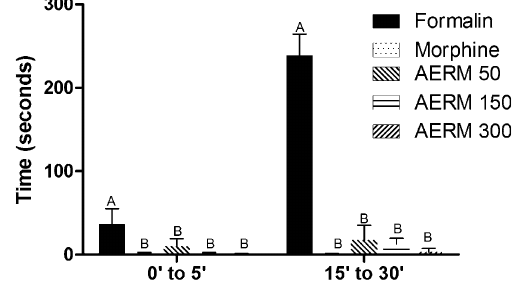
Fig. 4 Analgesic effect of AERM (50, 150 and 300 l g (cid:2) kg - 1 ) on Tail- flick test. Results are expressed as mean ± SEM (n = 6), p \